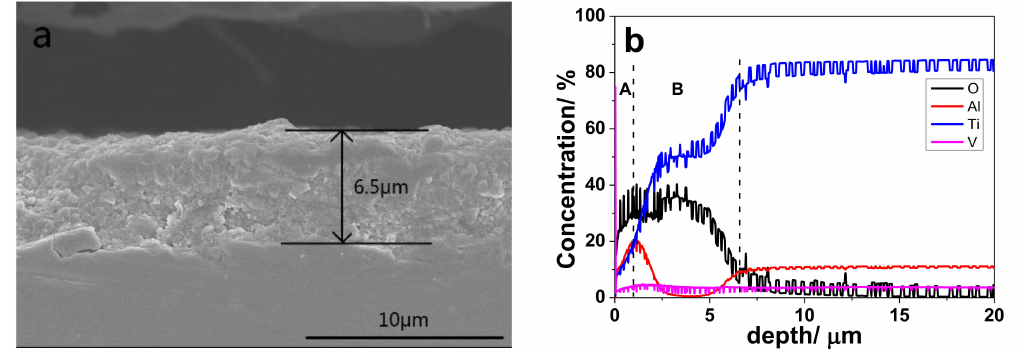
Figure 2. ( a ) Scanning electron microscope (SEM) image of the cross-sectional structure and ( b ) elements concentration depth profile measured by GDS across oxide structure on oxidized Ti6Al4V samples.